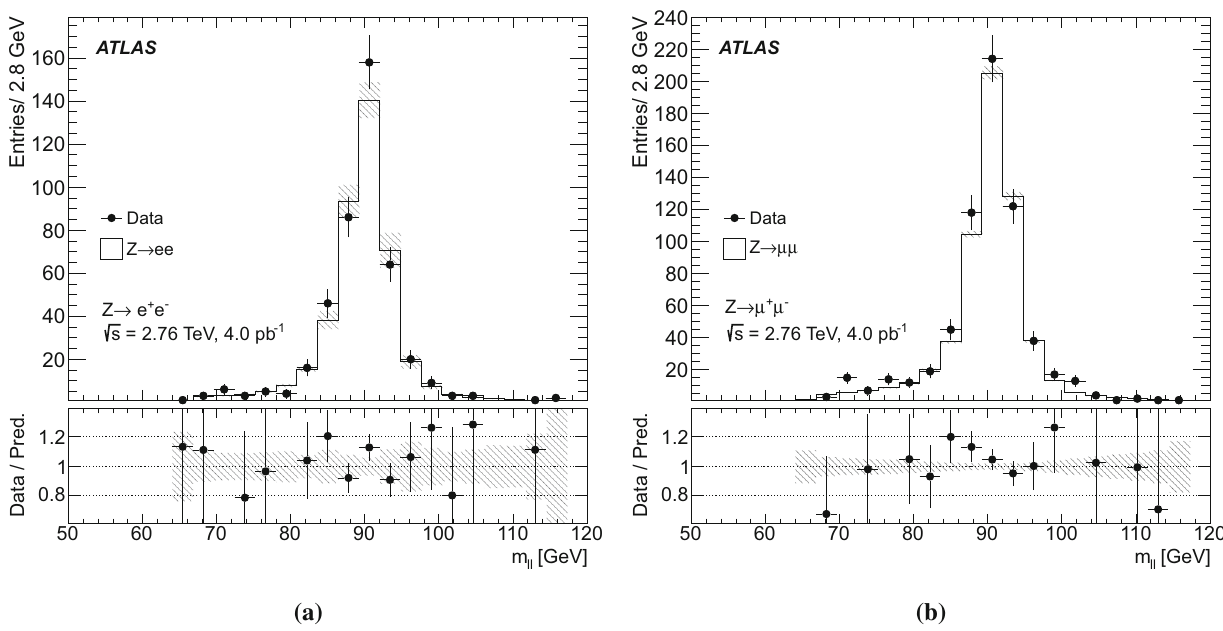
Fig. 3 The distribution of m (cid:3)(cid:3) for Z → (cid:3) + (cid:3) − candidate events. The expected signal, normalised to the NNLO theoretical predictions, is shown as an unfilled histogram. Systematic uncertainties for the signal andbackgrounddistributionsarecombinedintheshadedband.System-